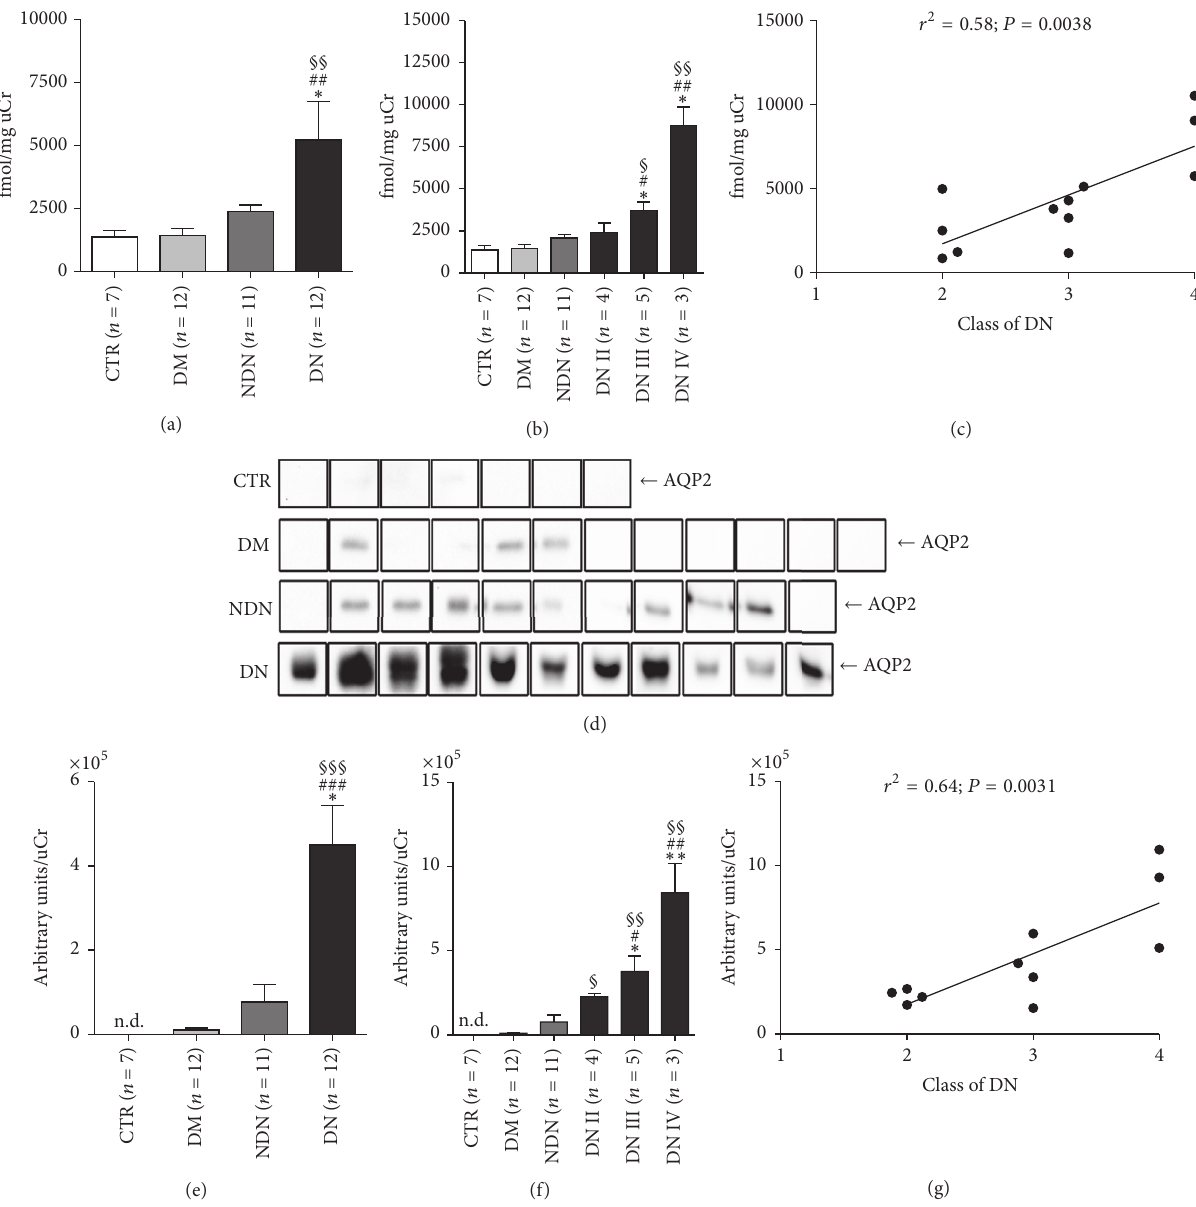
Figure 2: The urinary excretion of AQP2 dramatically increases in DN patients and positively correlates with the clinical severity of DN. (a) Urinary AQP2 excretion was measured by ELISA in urine samples of healthy subjects (CTR, 𝑛 = 7 ), patients with DM ( 𝑛 = 12 ), patients with NDN ( 𝑛 = 11 ), and patients with DN ( 𝑛 = 12 ) and expressed as fmol/mg urine creatinine. All data are reported as mean ± SEM. §§ 𝑃 < 0.01 versus CTR, ## 𝑃 < 0.01 versus DM, and ∗ 𝑃 < 0.05 versus NDN, obtained by Kruskal-Wallis one-way ANOVA test. (b) DN patients were grouped according to the histological changes evaluated by kidney biopsy: DN stage II ( 𝑛 = 4 ), DN stage III ( 𝑛 = 5 ), and DN stage IV ( 𝑛 = 3 ) and uAQP2 at each stage compared to uAQP2 in DM and NDN patients. All data are reported as mean ± SEM. §§ 𝑃 < 0.01 and § 𝑃 < 0.05 versus CTR, ## 𝑃 < 0.01 and # 𝑃 < 0.05 versus DM, and ∗ 𝑃 < 0.05 versus NDN, obtained by Kruskal-Wallis one-way ANOVA test. (c) Linear regression analysis of uAQP2 abundance, as measured by ELISA, with the class of DN ( 𝑟 2 = 0.58 ; 𝑃 = 0.0038 ). (d) Exosomes were isolated from urine of healthy subjects (CTR, 𝑛 = 7 ), patients with DM ( 𝑛 = 12 ), patients with NDN ( 𝑛 = 11 ), and patients with DN ( 𝑛 = 11 ) using the two-step differential centrifugation method. Total exosome proteins were resolved on 12% SDS-PAGE and analyzed by Western blotting for AQP2 abundance. (e) Densitometry analysis of the uAQP2 band intensities was normalized for uCr and reported as means ± SEM. §§§ 𝑃 < 0.001 versus CTR, ### 𝑃 < 0.001 versus DM, and ∗ 𝑃 < 0.05 versus NDN, obtained by Kruskal-Wallis one-way ANOVA test. (f) DN patients were grouped according to the histological changes evaluated by kidney biopsy: DN stage II ( 𝑛 = 4 ), DN stage III ( 𝑛 = 4 ), and DN stage IV ( 𝑛 = 3 ) and densitometry analysis of uAQP2 at each stage compared to uAQP2 in CTR and DM and NDN patients. All data are reported as mean ± SEM. §§ 𝑃 < 0.01 and § 𝑃 < 0.05 versus CTR, ## 𝑃 < 001 and # 𝑃 < 0.05 versus DM, and ∗∗ 𝑃 < 0.01 and ∗ 𝑃 < 0.05 versus NDN, obtained by Kruskal-Wallis one-way ANOVA test. (g) Linear regression analysis of uAQP2 abundance, as semiquantified by Western blotting, with the class of DN ( 𝑟 2 = 0.64 ; 𝑃 = 0.0031